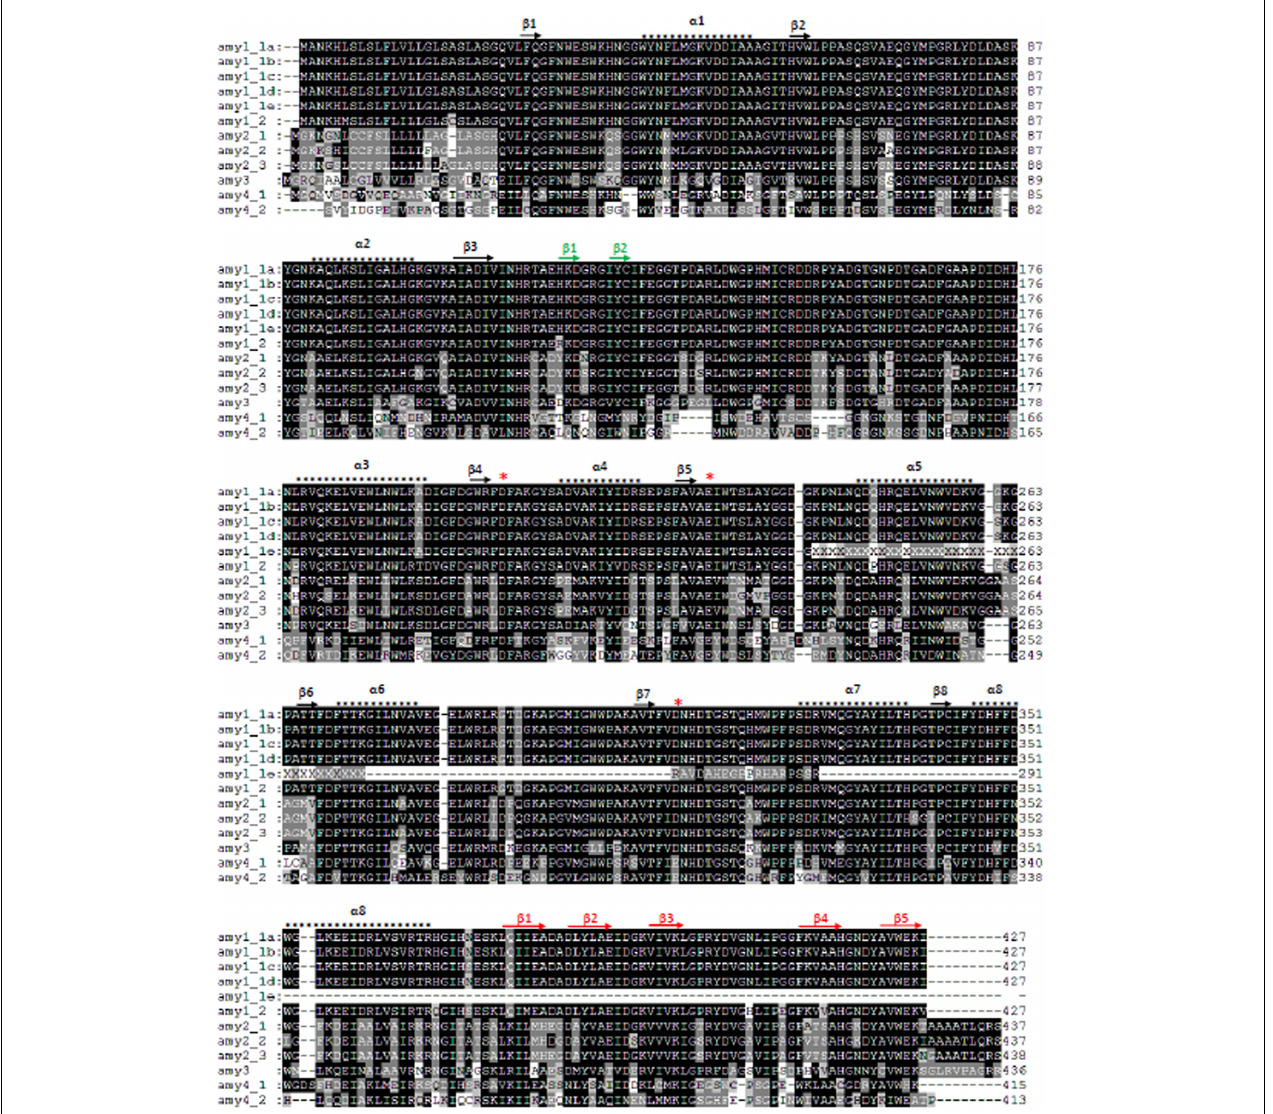
FIGURE 1 | Alignments and secondary structures of barley amy proteins. Barley amy1_1a and amy2_3 had 100% sequence identities with the two 3D structure-resolved barley amy proteins (1AMY and 1HT6), respectively (Kadziola et al., 1994; Robert et al., 2003). Their secondary structure features are shown on top of the alignments. There are three domains: domain A (black arrows and asterisks), domain B (green arrows), and domain C (red arrows). Domain A consists of a ( α / β ) 8 barrel, while domain C has five β -sheets. The three catalytic amino acids Asp 203 , Glu 228 , and Asp 310 are indicated by red asterisks (amy1_1a